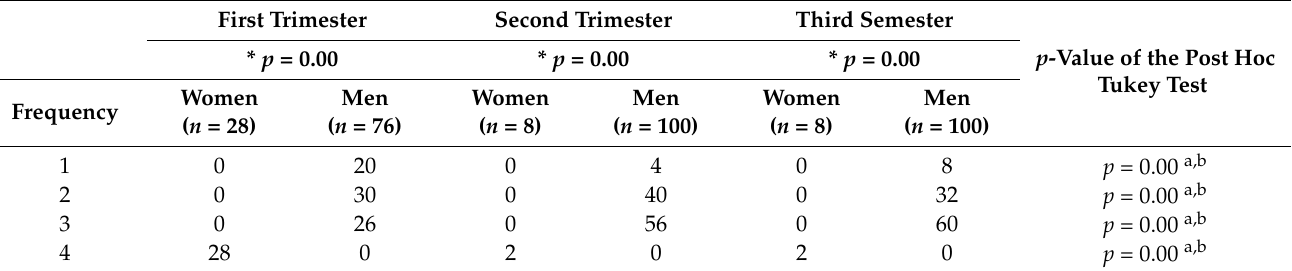
Table 4. Masturbation during